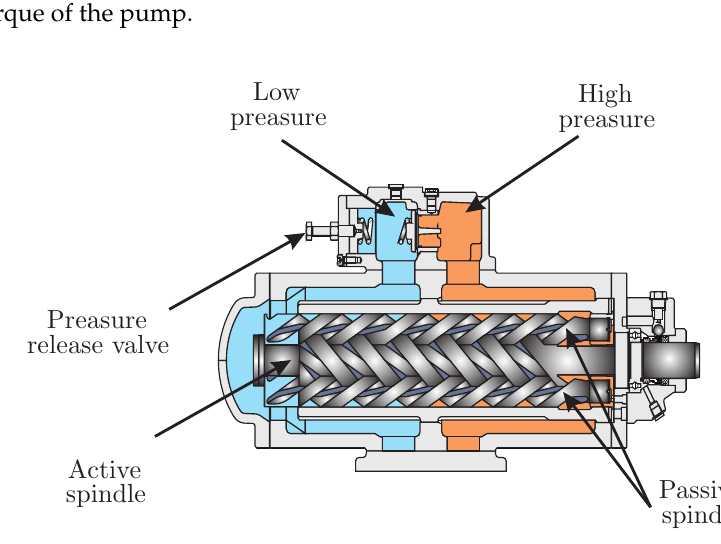
Figure 6. Three-screw spindle oil